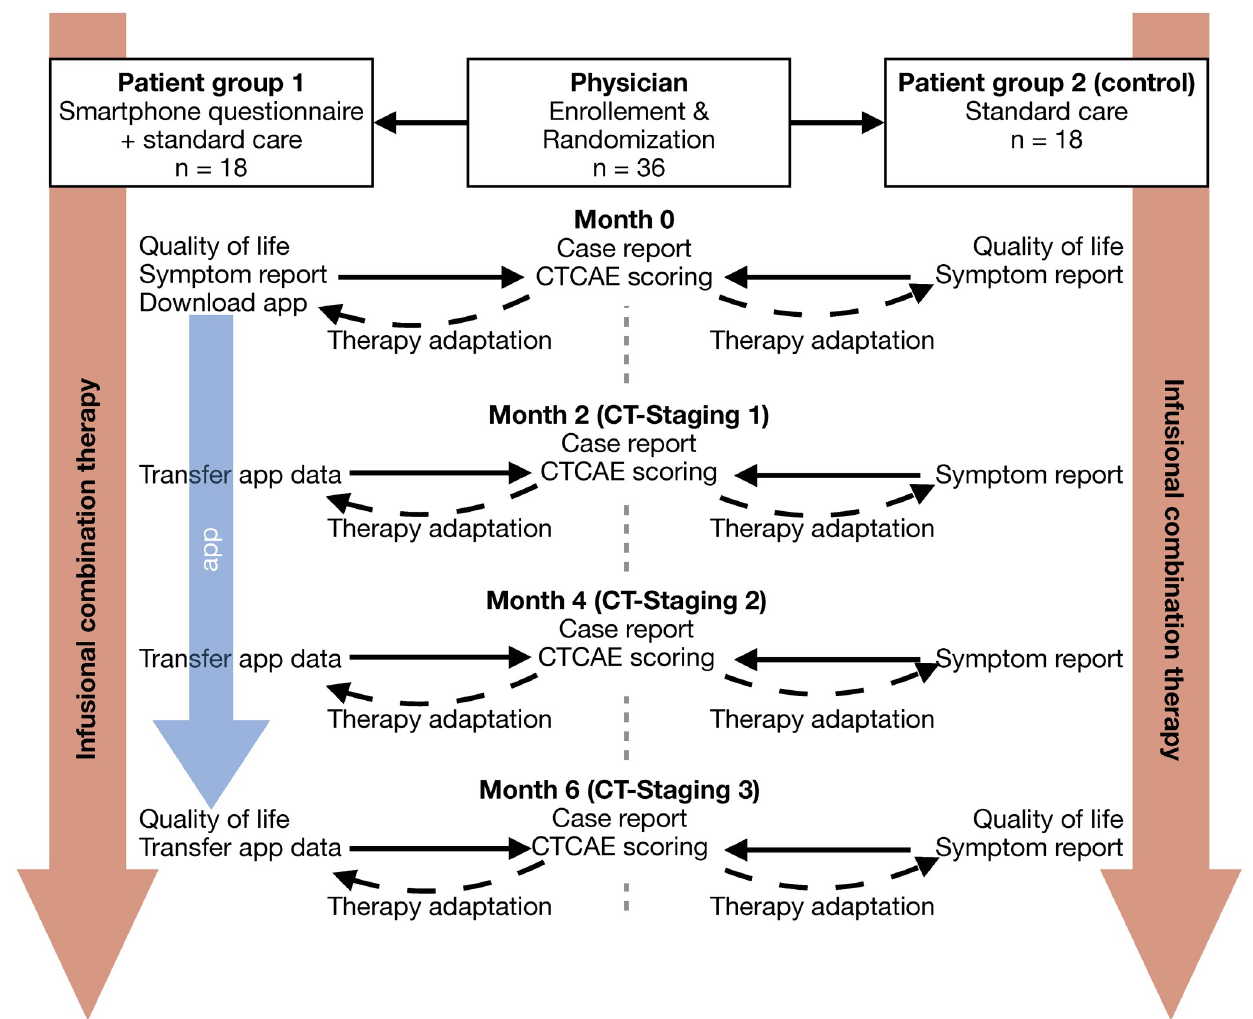
Fig 1. Second part trial design. Patients who are treated with infusional combination therapy will report their occurred adverse events (symptoms) every two months to physicians. Group 1 will use a smartphone app with standardized answers to report symptoms while it depends on the patients of group 2 which symptoms they